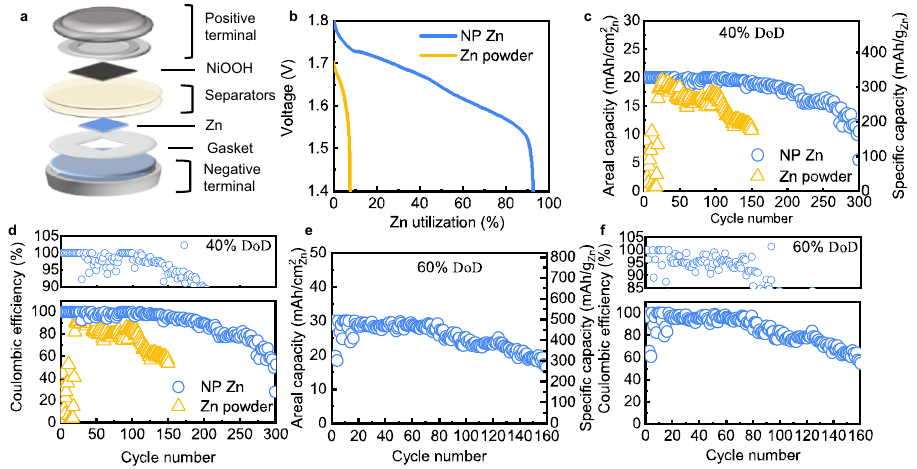
Fig. 5 Electrochemical performances of Zn | |NiOOH full cells. a Schematic of Zn||NiOOH coin cell used in this study. b The Zn utilization of different anodes in primary Zn | |NiOOH alkaline batteries. c Discharging capacities of the NP Zn and Zn powder anodes at 40% DoD vs. the cycle number. d Coulombic ef fi ciency of the NP Zn and Zn powder in the lean electrolyte at 40% DoD, with an additional y -axis (between 90 and 105%) at the top to clearly show the ef fi ciency in the fi rst 100 cycles. e Discharging capacities of the NP Zn anode at 60% DoD. f Coulombic ef fi ciency of the NP Zn in the lean electrolyte at 60% DoD, with an additional y -axis (between 85 and 105%) at the top to show the ef fi ciency in the fi rst 100